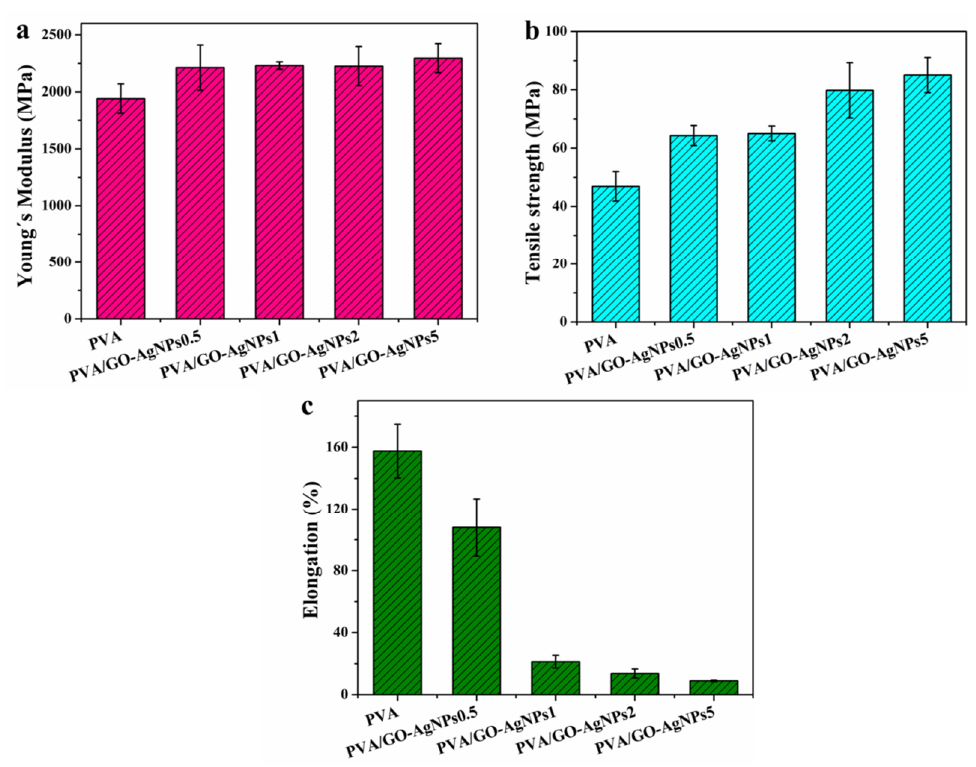
Figure 6. Tensile properties of neat PVA, and PVA / GO–AgNPs nanocomposites. ( a ) Young´s modulus; ( b ) tensile strength; ( c ) elongation at break.